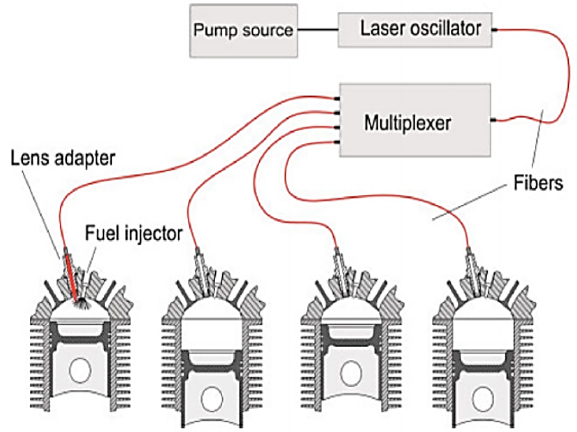
Figure 10: Schematic representation of laser ignition system, where the laser beam is distributed by optical fibers to multiple engine cylinders. The laser source includes a pump source and oscillator, whereas an optical multiplexer is needed for routing the light beam towards the different engine cylinders